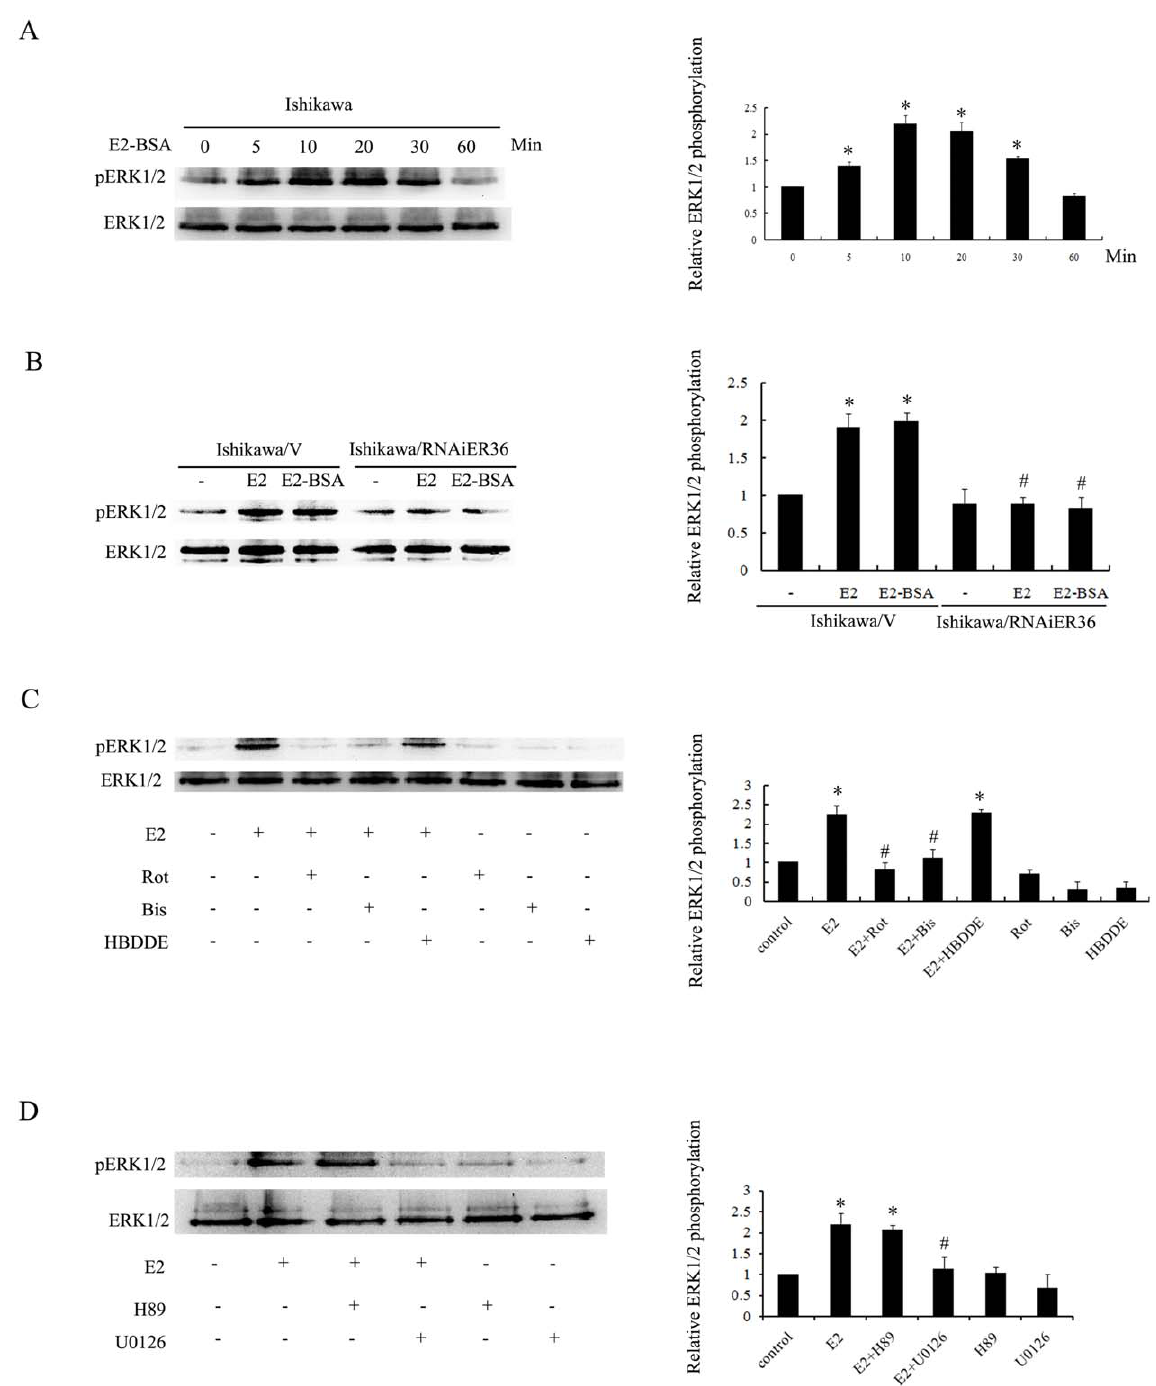
Figure 4. E2 activates the ERK1/2 through the PKC d signaling pathway. A. Serum starved Ishikawa cells were treated with E2-BSA for indicated time points and cell lysates were immunoblotted with antibody against phosphorylated ERK1/2. Levels of phosphorylation were normalized with the total ERK1/2 protein, and each bar represents means value 6 SEM (n=3). *, P , 0.05 compared to untreated cells. B. Ishikawa/V and Ishikawa/ RNAiER36 cells were treated with 10 nM E2 or 10 nM E2-BSA for 10 min, and ERK1/2 phosphorylation was analyzed with Western blot. Expression was normalized to total ERK1/2, and each bar represents mean value 6 SEM (n=3).*, P , 0.05 compared to untreated cells. # , P , 0.05 compared to E2- or E2-BSA-treated Ishikawa/V cells. C. Serum starved Ishikawa cells were treated with 10 nM E2 or together with 5 m M of PKC d specific inhibitor rottlerin, 5 m M of pan-PKC inhibitor bisindolylmaleimide or 40 m M of PKC a specific inhibitor HBDDE. ERK1/2 phosphorylation was analyzed with Western blot. Expression was normalized to total ERK1/2, and each bar represents mean value 6 SEM (n=3). *, P , 0.05 compared to untreated cells. # , P , 0.05 compared to E2-treated Ishikawa cells. D. Serum starved Ishikawa cells were treated with 10 nM E2 or together with 5 m M of PKA specific inhibitor H89 or 10 m M of MEK inhibitor U0126, and ERK1/2 phosphorylation was analyzed by Western blot. Expression was normalized to total ERK1/2, and each bar represents mean value 6 SEM (n=3). *, P , 0.05 compared to untreated cells. # , P , 0.05 compared to E2-treated Ishikawa cells.